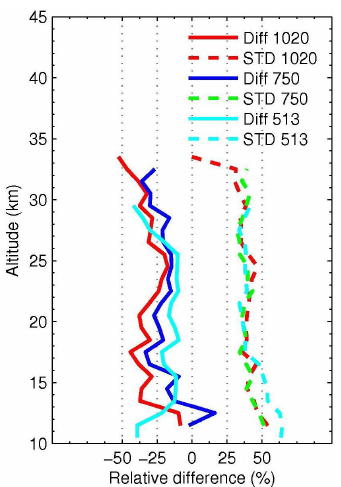
Fig. 13. Summary plot of the relative difference (percent) for all retrieved aerosol extinction profiles used in this study with SAGE II, which includes 1028nm (red), 750nm (blue) and 513nm (cyan). The dashed lines are the standard